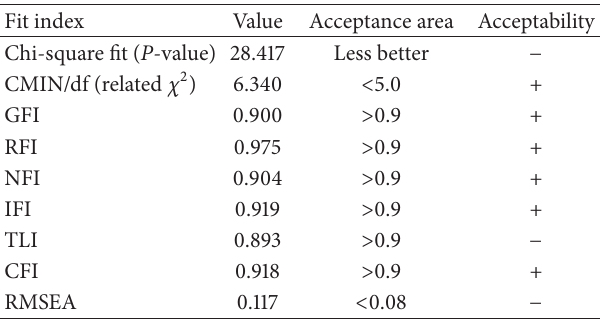
Table 4: Modified factor loading for parental feeding